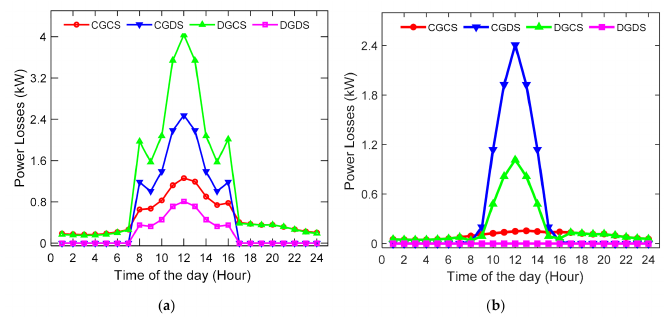
Figure 10. ( a ) Time-varying power electronic conversion losses of the four architectures ( b ) time-varying distribution losses of the four